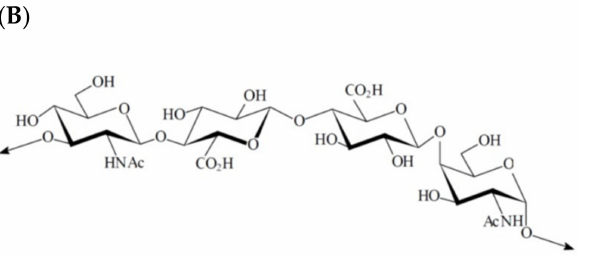
Figure 4. Chemical structure of marine exopolysaccharides: ( A ) GY785, and ( B ) HE800 EPS (adapted from refs.